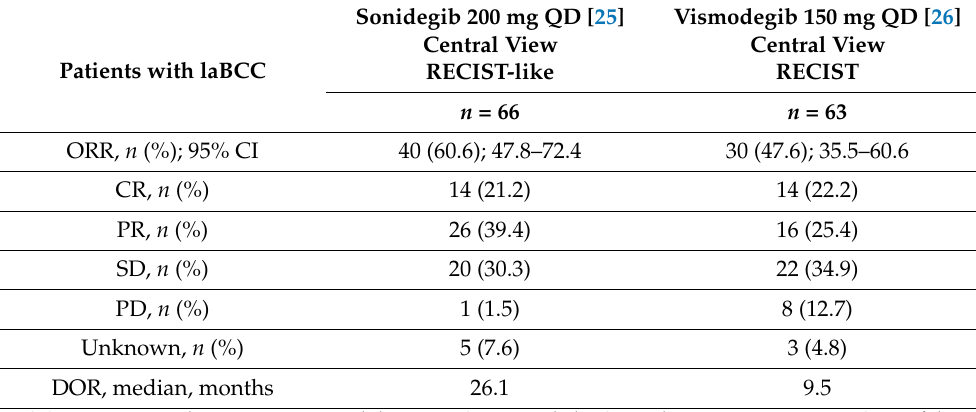
Table 1. Efficacy of sonidegib (18-month analysis) and vismodegib (21-month analysis) in patients with laBCC per RECIST